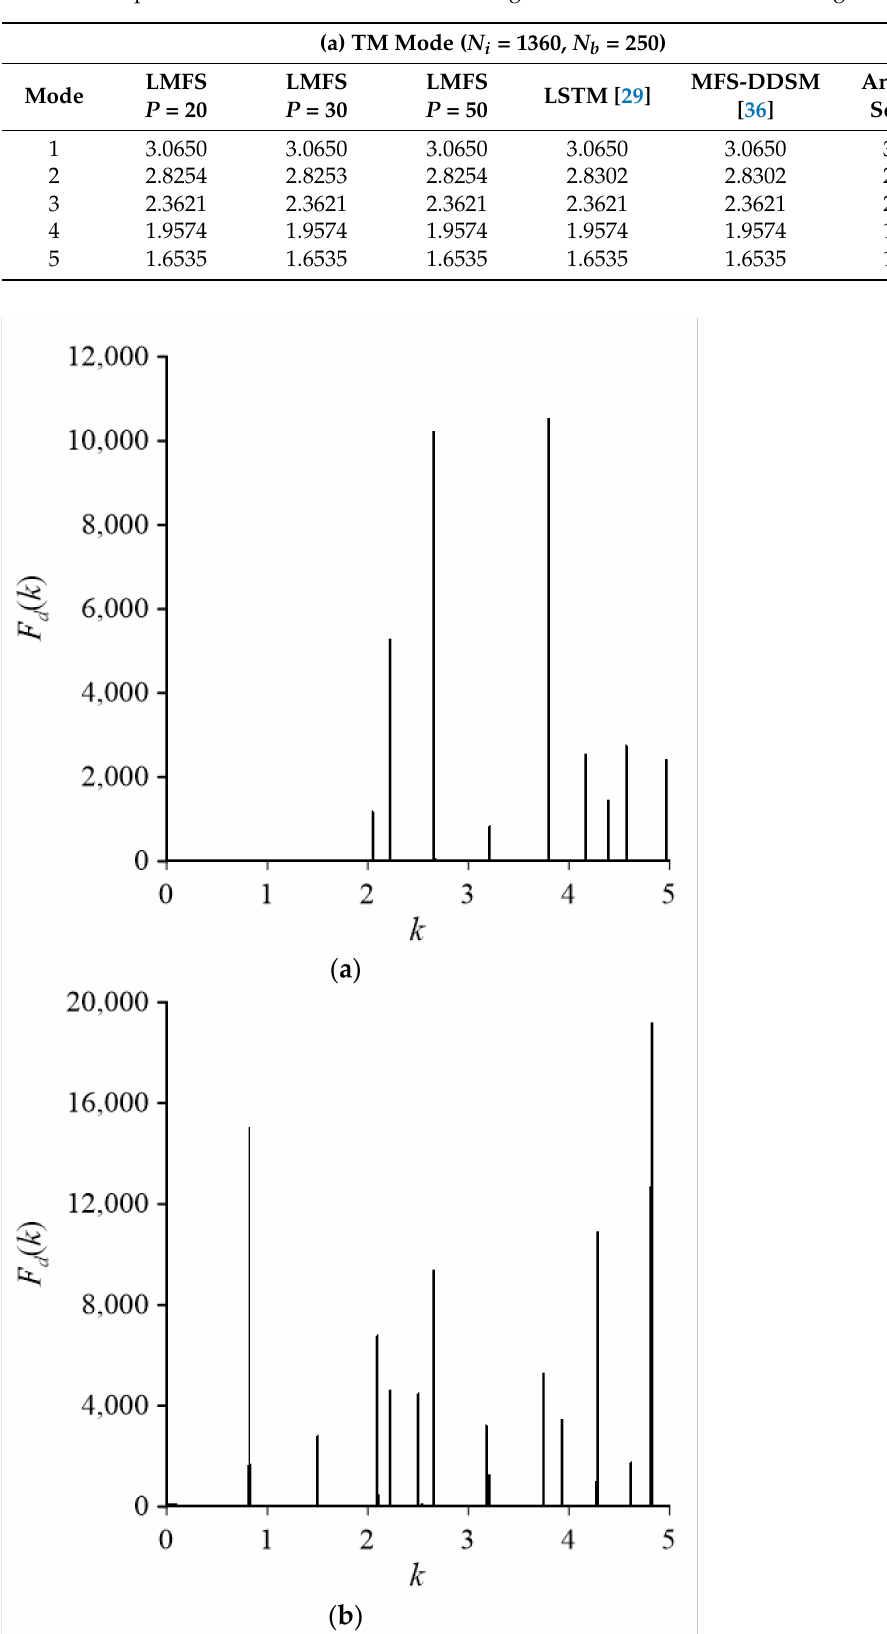
Table 2. Comparison of the first five cutoff wavelengths for concentric annular waveguide in case 2.